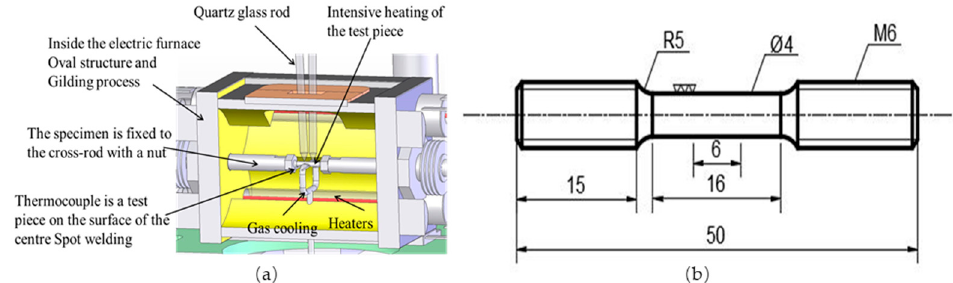
Figure 3. Inner construction of an electric furnace and tensile sample. ( a ) Inner construction of an electric furnace; ( b ) tensile sample.